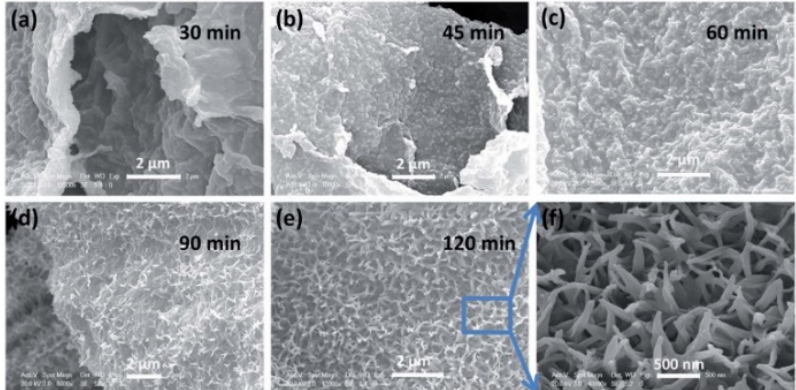
Figure 2. SEM images of N ‐ doped rGO anchored to vertically aligned V 2 O 5 nanowires after solvothermal synthesis for ( a ) 30, ( b ) 45, ( c ) 60, ( d ) 90, and ( e ) 120 min. ( f ) Magnified SEM image of the N ‐ doped VrG after solvothermal reaction for 120 min. Reprinted with permission from Ref. [57]. Copyright 2018 Royal Society of Chemistry.